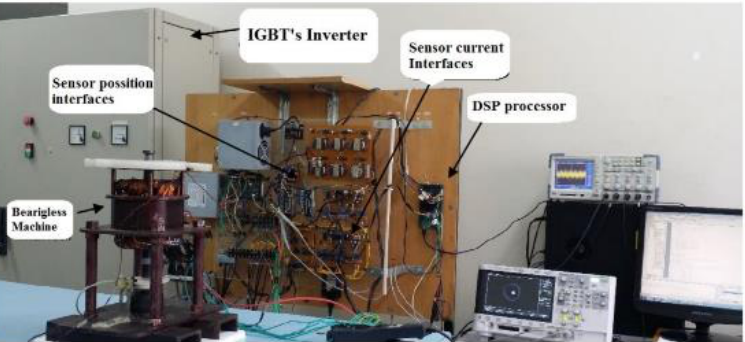
Figure 11. Experimental